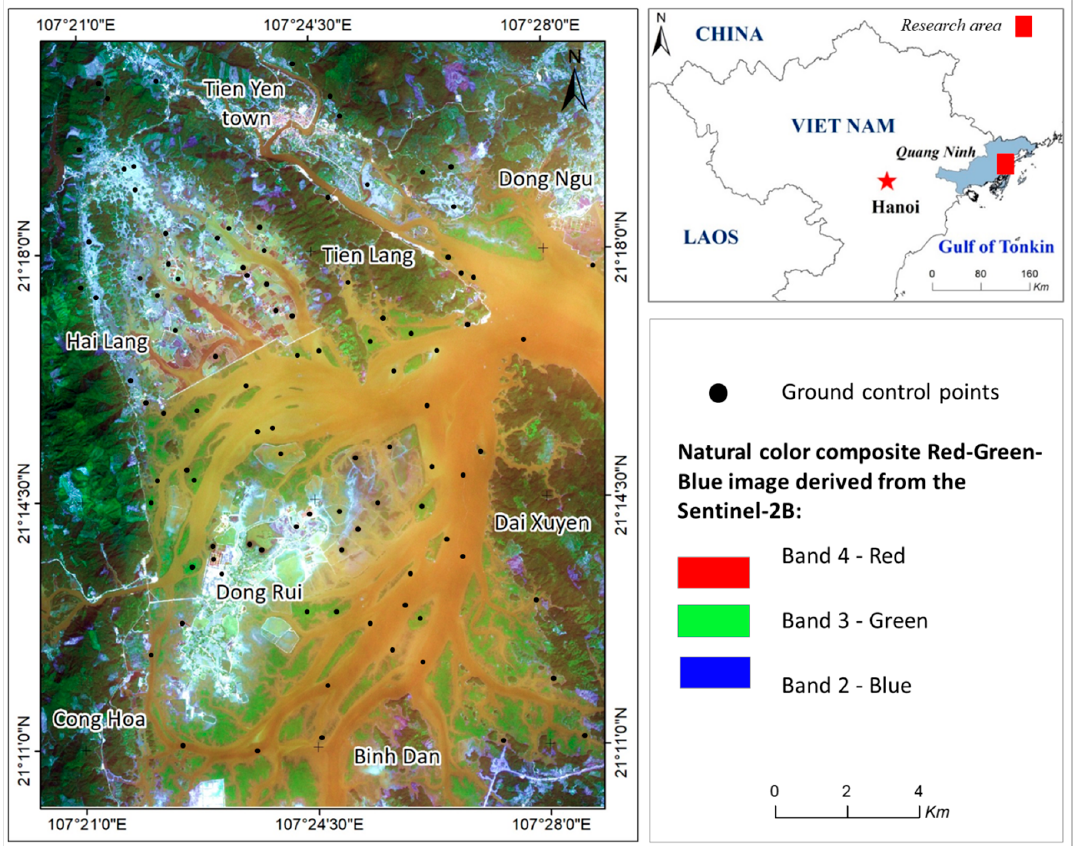
Figure 1. Study area on Sentinel-2 image obtained in 22 November 2019 and the location of ground control points (GCPs) in Tien Yen district, Quang Ninh province, Vietnam.